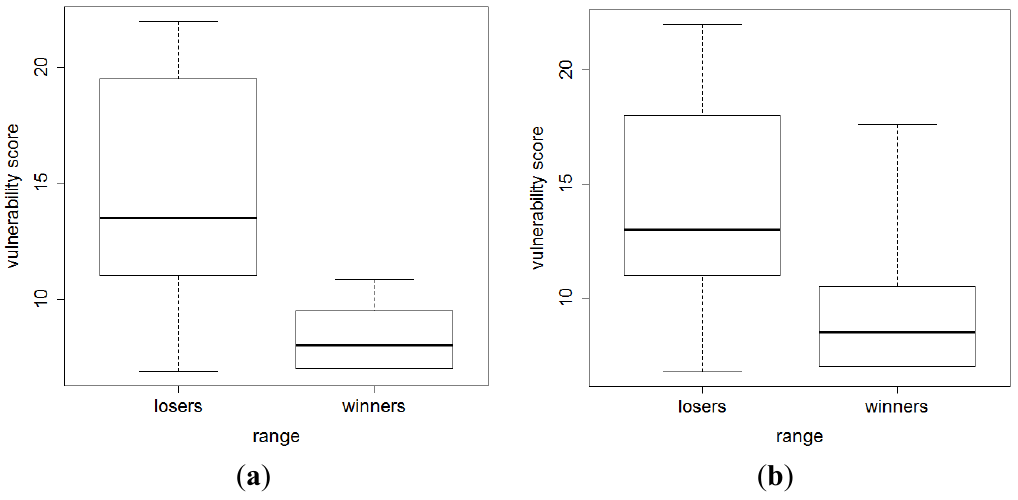
Figure 2. The relationship between mean latitude and whether a species was a “winner” or “loser”, in terms of changes in range size (number of grid cells predicted as climatically suitable), under emissions scenarios A1b ( a ) and A2 ( b ). Horizontal lines indicate median values; bottom and top of the boxes indicate 25th and 75th percentiles, respectively; and the error bars show 95% confidence intervals.